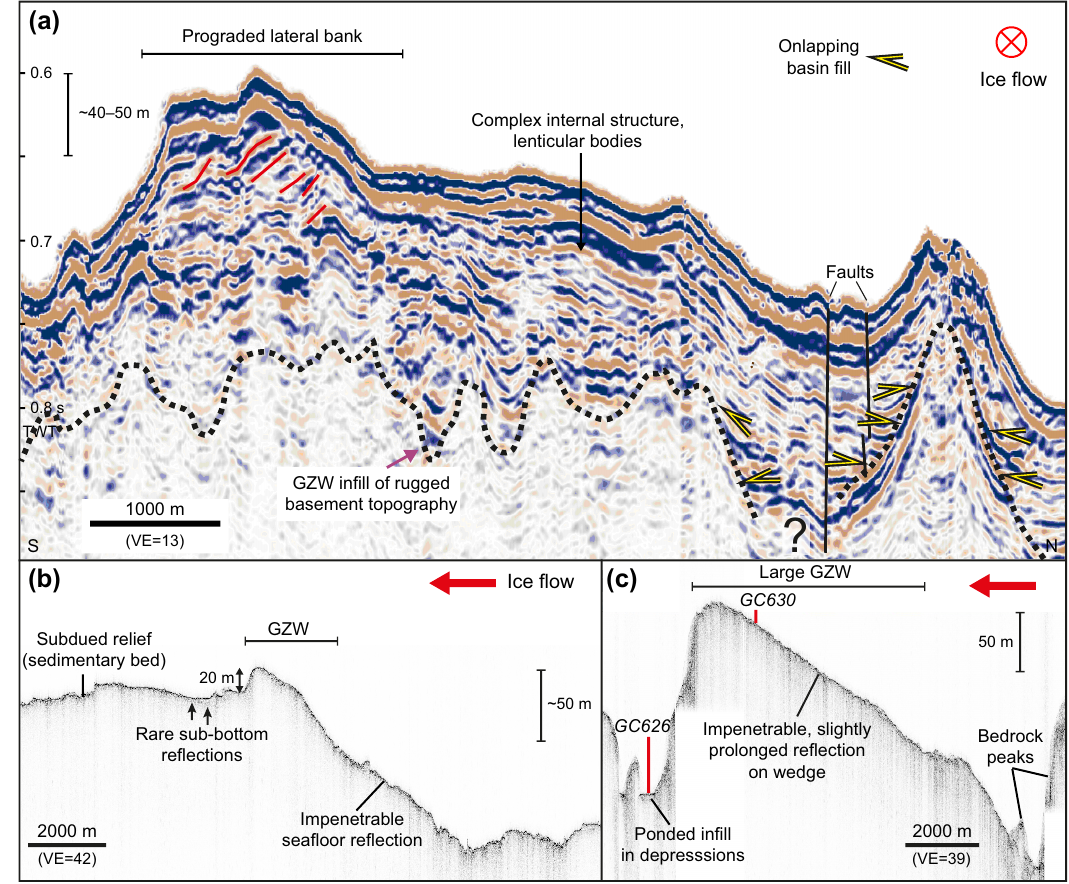
Figure 8. Seismic and sub-bottom parametric echo sounder profiles over GZWs on the Coats Land margin. (a) Seismic-reflection profile BAS101-s116 along-strike of the large GZW upstream of the deep basin in Dawson-Lambton Trough (location shown in Fig. 3a). This shows that the GZW consists of up to 80m of unconsolidated stratified sediment units over a rugged bedrock surface (black dotted line). Prograding strata are indicated by red lines, together with lenticular bodies and faults. Onlapping basin fills are marked by yellow arrowheads. Thickness bar on y axis calculated with 1.6–2.0kms − 1 . (b) TOPAS sub-bottom parametric echo sounder profile over a GZW in Albert Trough (for location see black dotted line in Fig. 3c). This shows generally impenetrable upper reflections. (c) TOPAS sub-bottom parametric echo sounder profile over the GZW in Dawson-Lambton Trough showing ponded sediment in depressions and the locations of coring sites GC630 and GC626 (for location see black dotted line in Fig. 3a). VE is the vertical exaggeration and TWT is the two-way travel time in seconds ( y